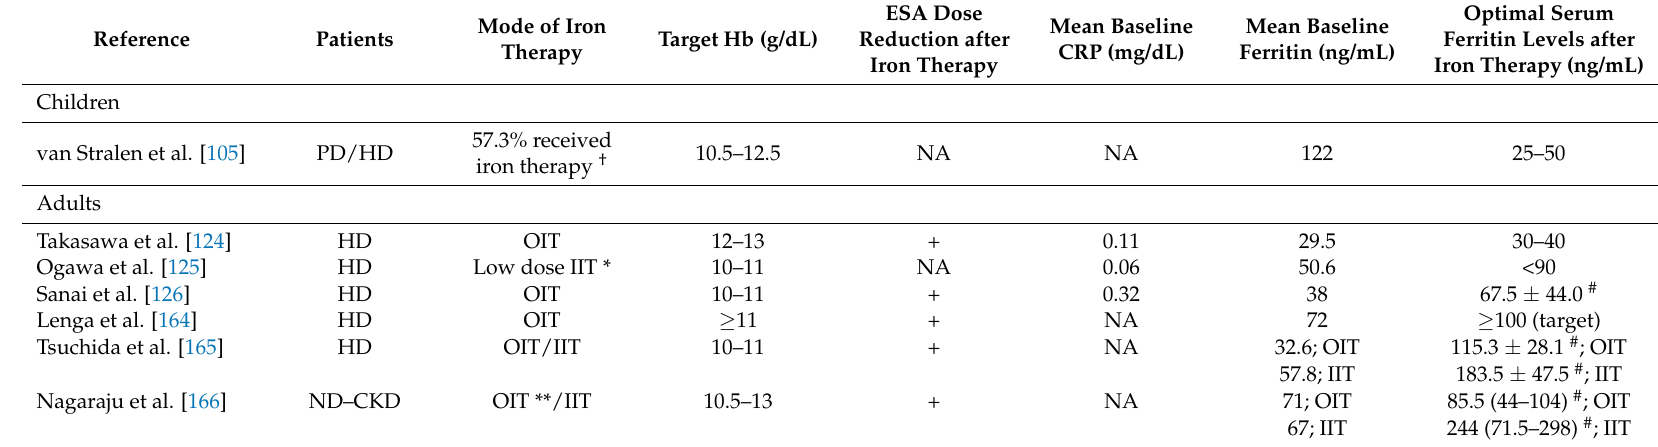
Table 4. Optimal levels of serum ferritin during iron therapy in CKD patients with minor inflammation or lower serum ferritin